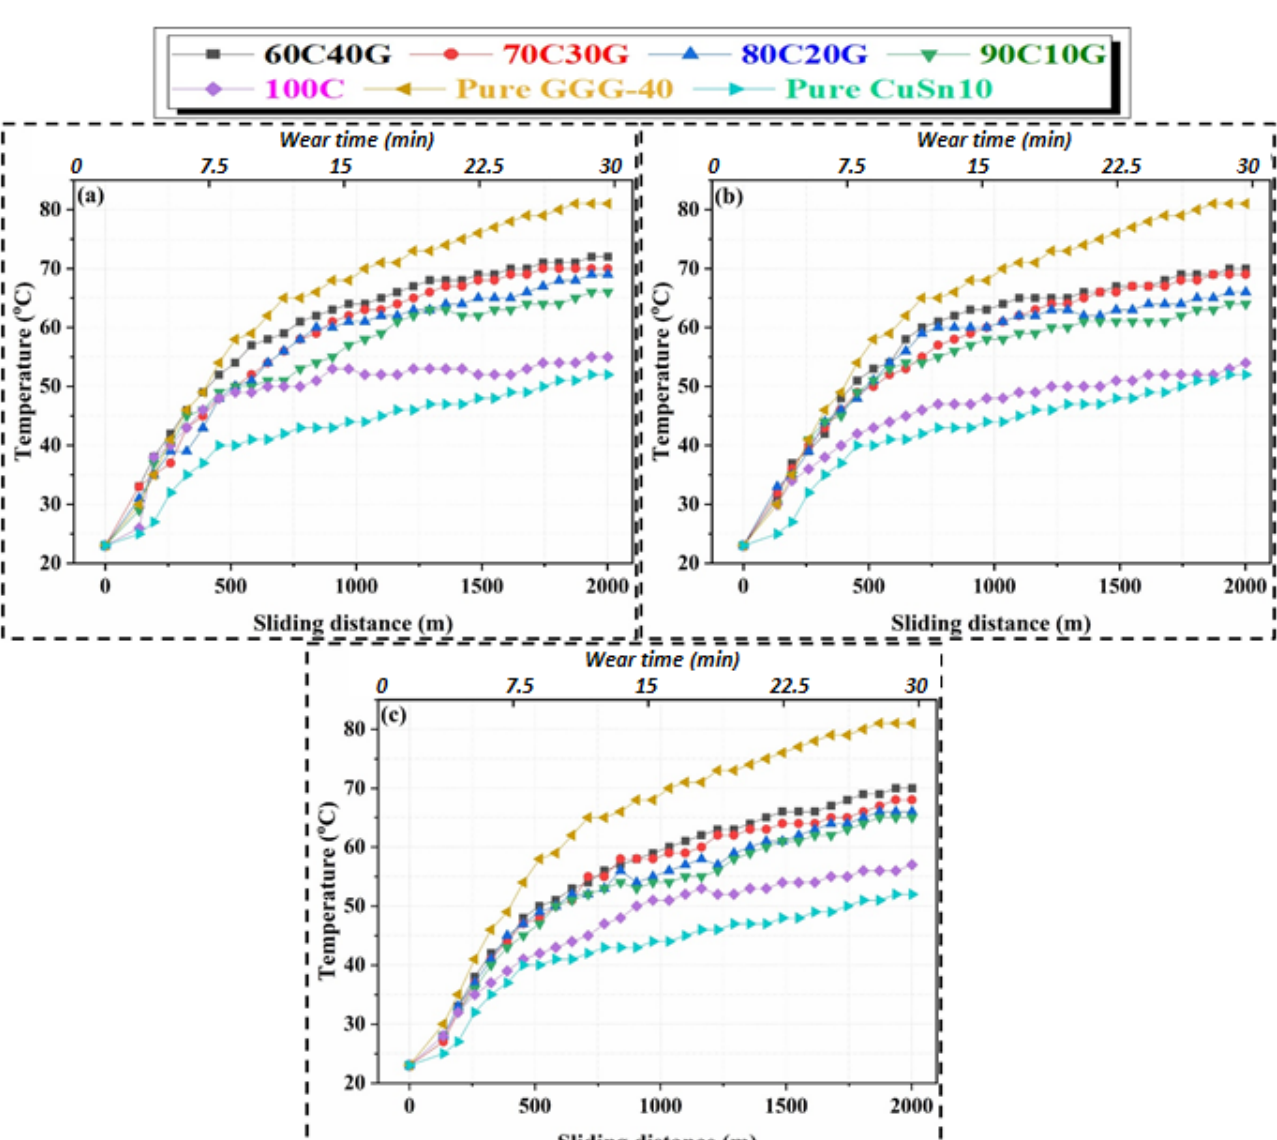
Figure 8. Contact zone temperature changes of ( a ) 480 MPa, ( b ) 640 MPa, and ( c ) 820 MPa MMCs produced at 400 °C according to sliding distance and wear time.